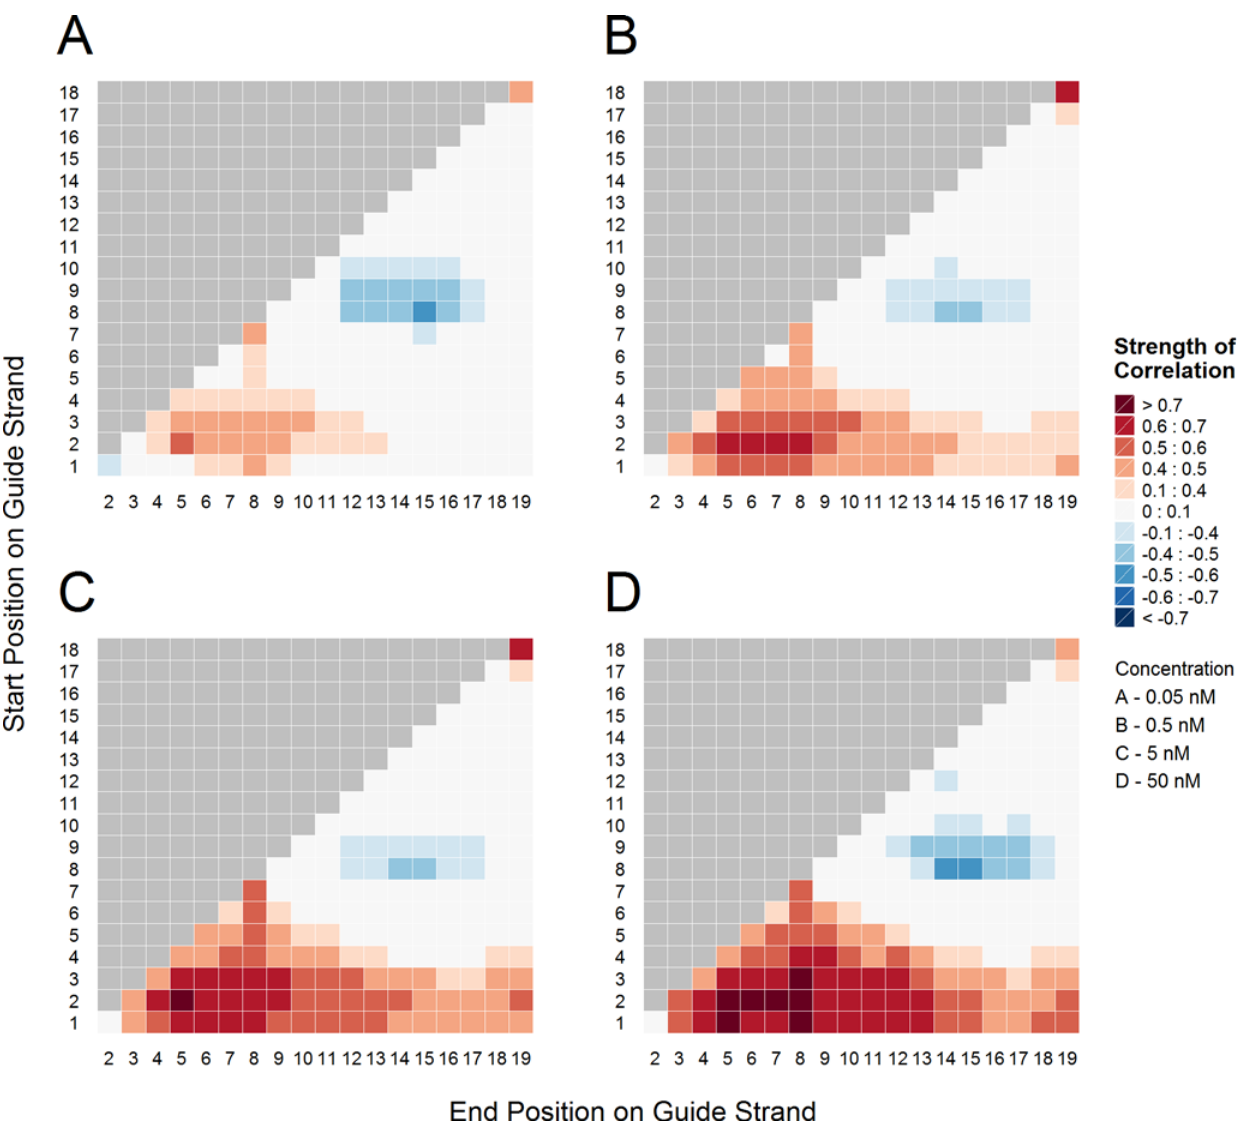
Fig 2. Correlation between T m values of sequence subsections within siRNA duplexes and the corresponding off-target silencing efficiency. The start of the subsection within a duplex is plotted on the Y axis ( ‘ Start Position ’ ) whereas the end of the subsection is plotted on the X axis ( ‘ End Position ’ ). The position numbering mirrors that used in Fig 1. The analysis was performed separately for each siRNA concentration – (A) 0.05, (B) 0.5, (C) 5 and (D) 50 nM. The siRNA sequences used in the analysis, together with corresponding knockdown percentages, are listed in S1 Table.